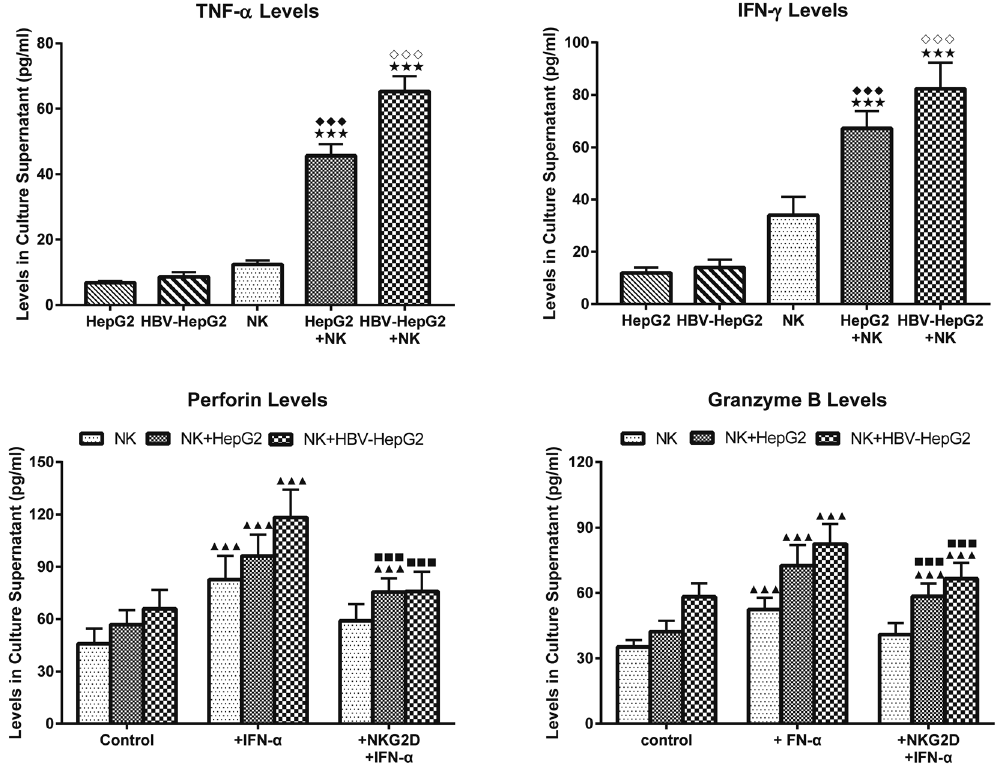
Figure 6. Levels of TNF- α ( a ) and IFN- γ ( b ) in the supernatants with or without co-cultured NK cells. Student- Newman-Keuls q test following one-way ANOVA were used for comparing IFN- γ , TNF- α , perforin and granzyme B levels between two compared groups. Compare with HepG2 cells group, ◆◆◆ P < 0.01; Compare with HBV-HepG2 cells group, ◇◇◇ P < 0.01; Compare with NK cells group, ★★★ P < 0.01. Levels of perforin ( c ) and granzyme B ( d ) in the supernatants in the presence IFN- α with or without NKG2D blocking. Compare with control group, ▲▲▲ P < 0.01; Compare with + IFN- α group, ■■■ P <